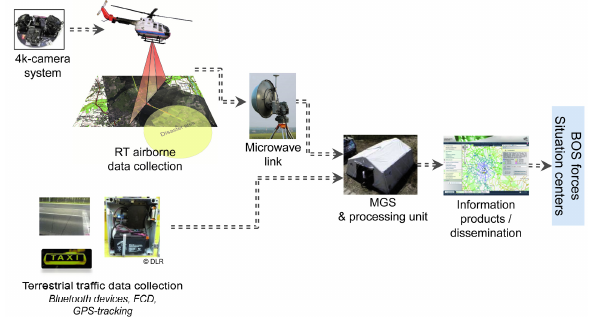
Figure 1. RT monitoring system of VABENE++ Pre-processed aerial imagery, extracted traffic information and information collected from ground based in-situ sensors are centrally stored and further processed at a mobile ground station (MGS). It is the central place where data aggregation, visualisation as well as product generation and dissemination take place. This study particularly focusses on the downstream components of the described workflow, i.e., after aerial imagery has been transmitted to and received at the